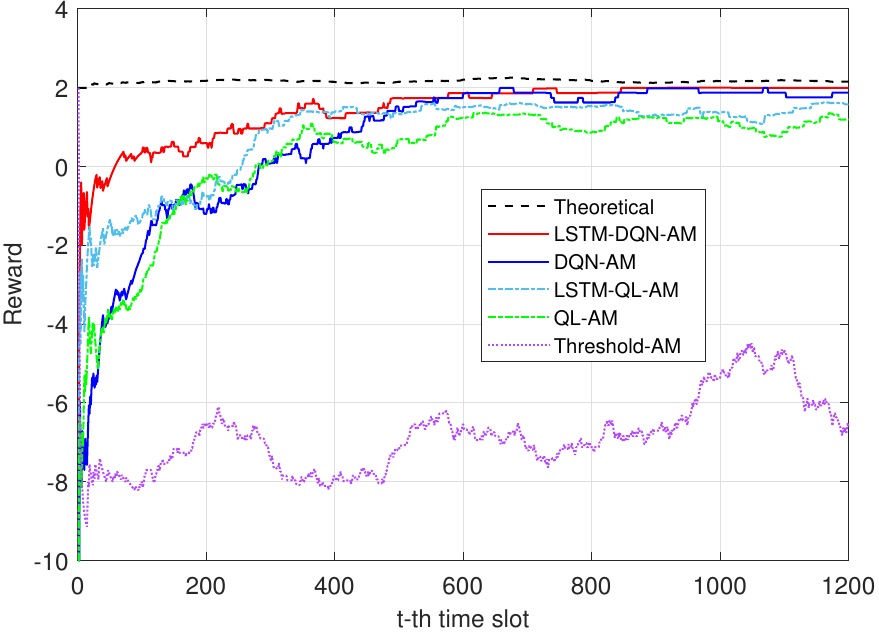
Figure 13. The rewards of the AM schemes in the sea experiments. Table 3. A comparison of the rewards of the different AM schemes in the sea experiments. AM Scheme Compared AM